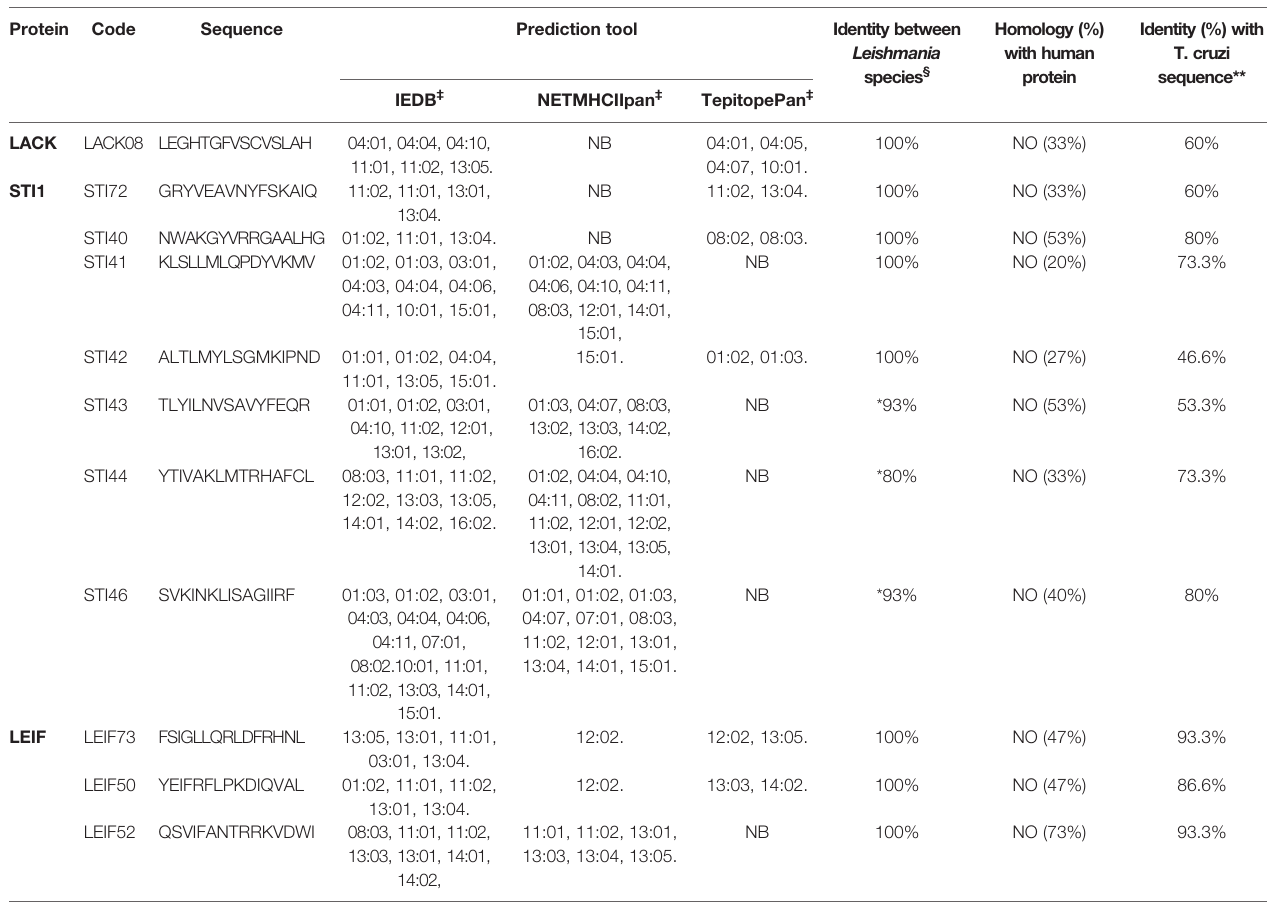
TABLE 1 | In silico analysis of binding prediction to HLA-DR alleles. Protein Code Sequence Prediction